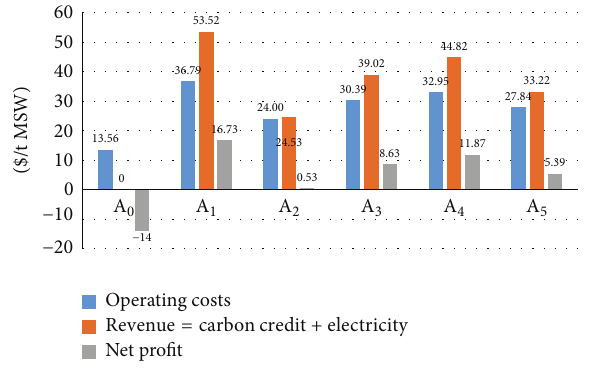
Figure 9: Costs and profit analysis of different WtE scenarios in Dhaka and Chittagong city, Bangladesh.